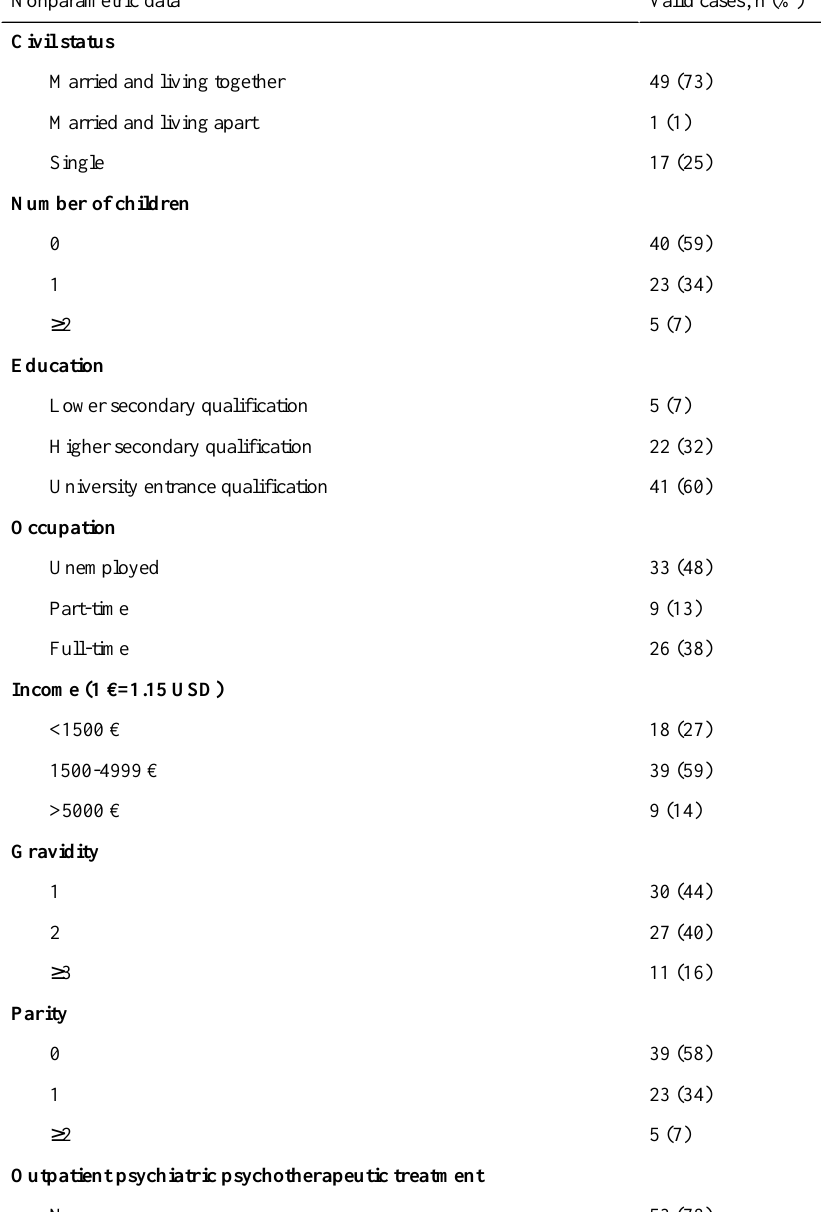
Table 4. Analysis of the nonparametric sample characteristics.